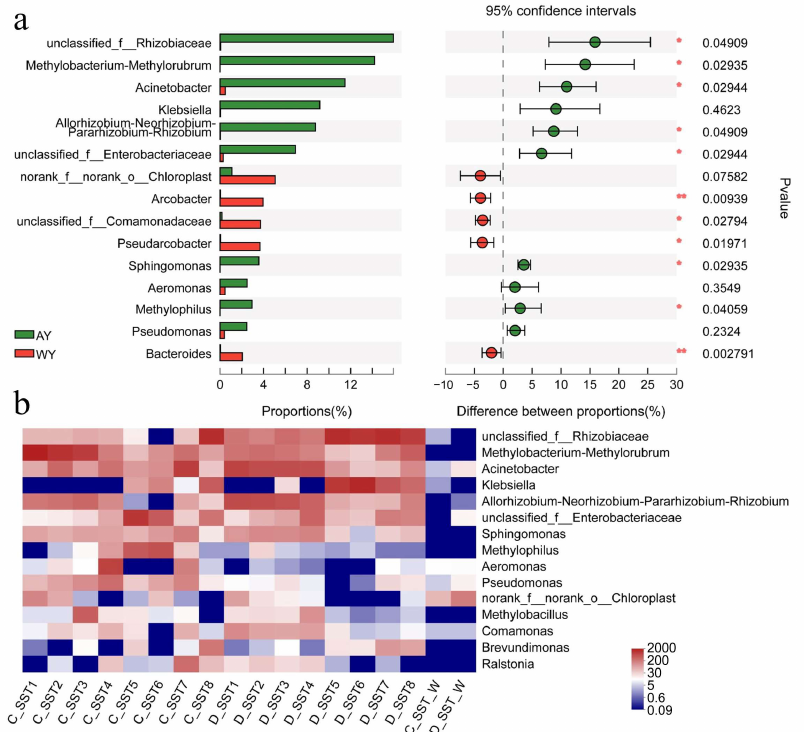
Figure 6. ( a ) The difference in species composition at the top 15 genus level of relative abundance among wastewater (WY: red) and aerosols (AY green) in SST. ( b ) Heat map of the main 15 bacterial genera in SST. The color gradient indicates the size of the proportion of species. 1–8: represent eight size stages. D_SST: secondary settling tank of Plant D; C_SST: secondary settling tank of Plant C; A: aerosol sample; W: water sample.